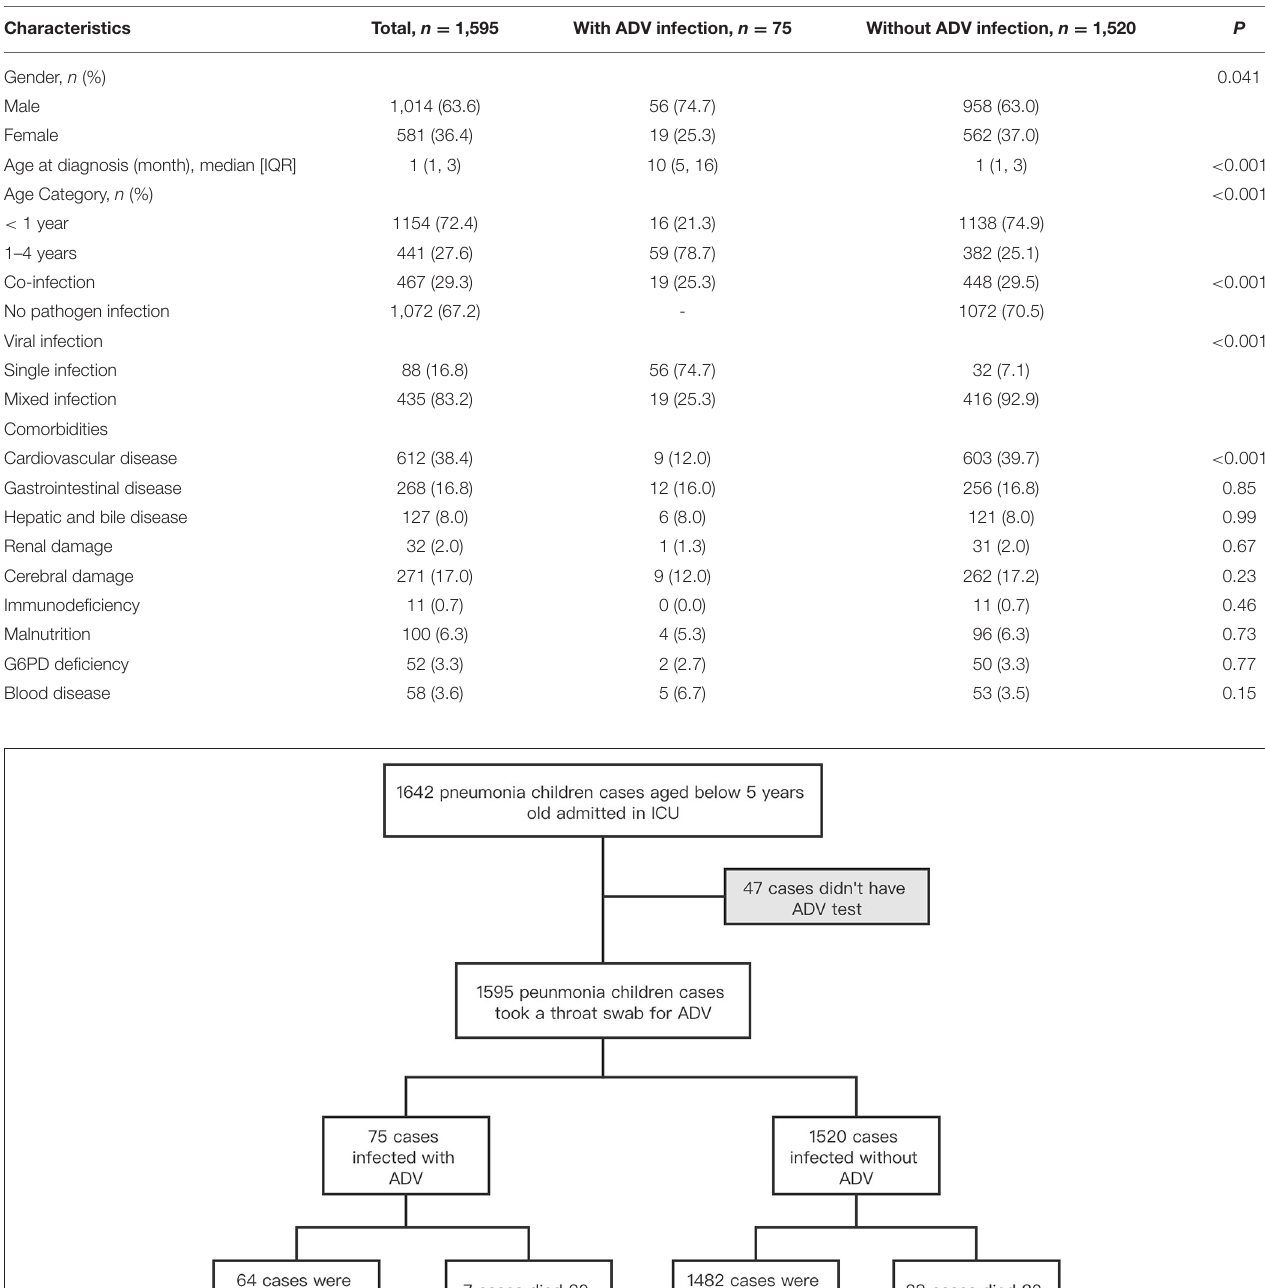
TABLE 1 | Characteristics of 1,595 children with severe pneumonia with and without ADV infection. Characteristics